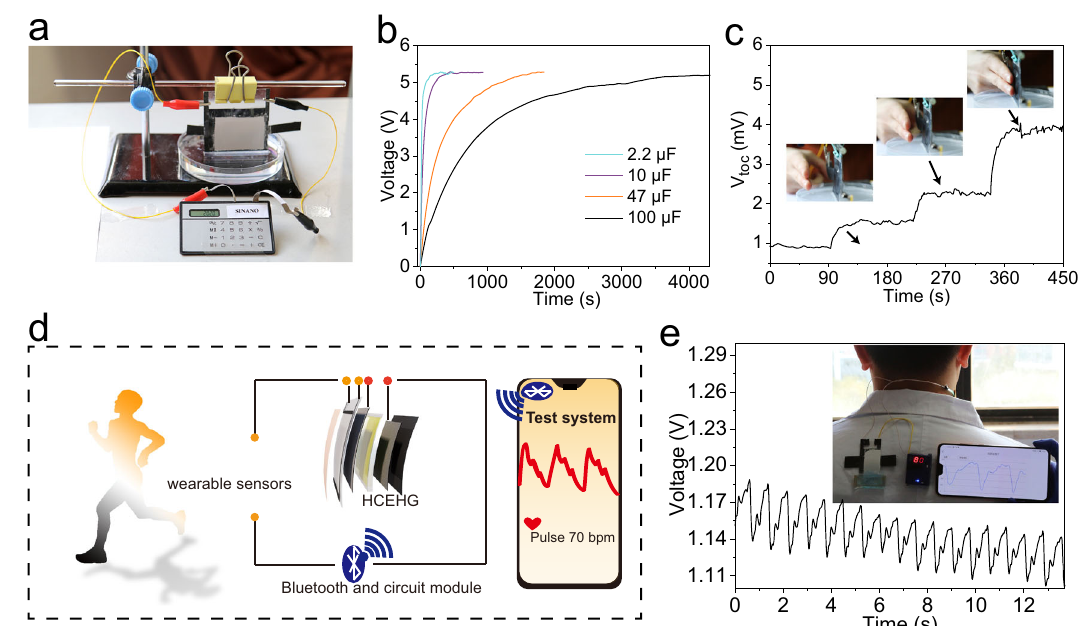
Fig. 5 Applications of the HCEHG. a Photograph of a digital calculator driven by the HCEHG. b Real-time voltage change of commercial capacitors when charged by the d -Al 2 O 3 HG part of the HG under sunlight. c Real-time voltage change of the thermoelectric module when index and middle fi ngers approach it, from 5 cm to 2.5 cm to 0 cm. d Schematic diagram of a wearable power-sensor system including the HCEHG, a fl exible CNT pressure sensor and a Bluetooth device. e Real-time pulse curve detected by attaching the HG-driven sensor to the carotid artery. Inset: photograph showing the testing process and graphical display by a mobile